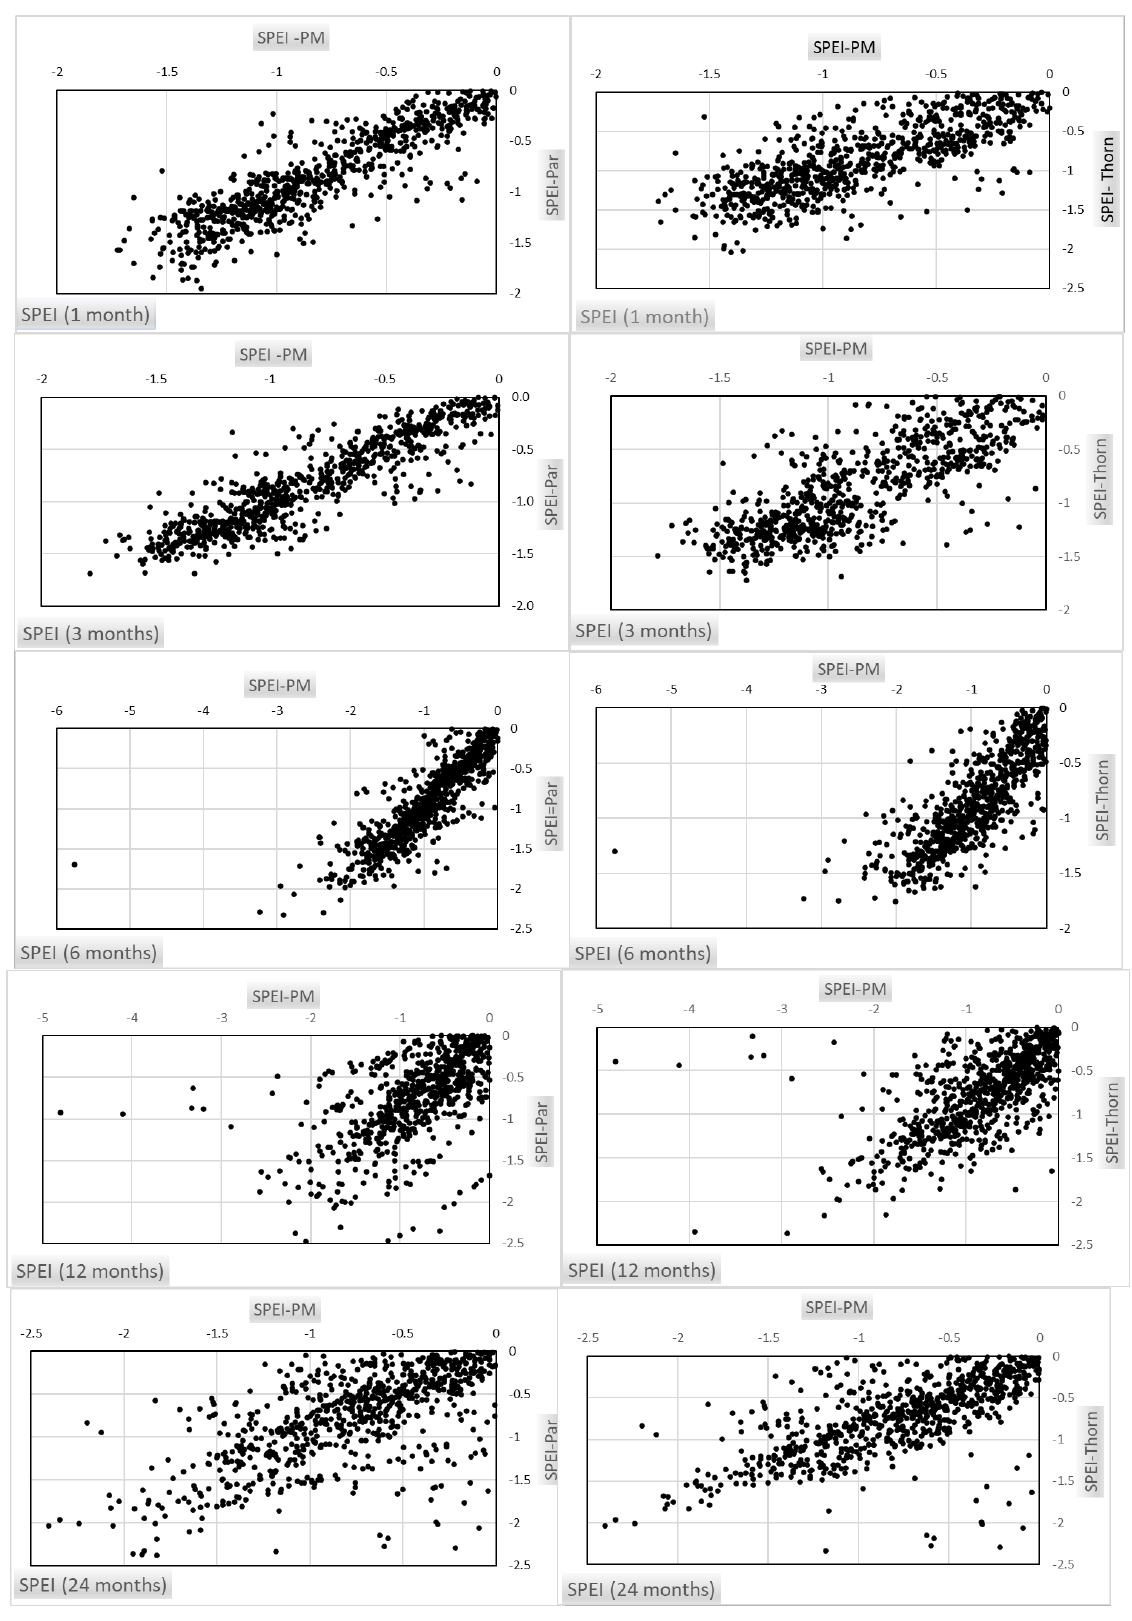
Figure 4. SPEI drought empirical plots (samples from five gauge stations).